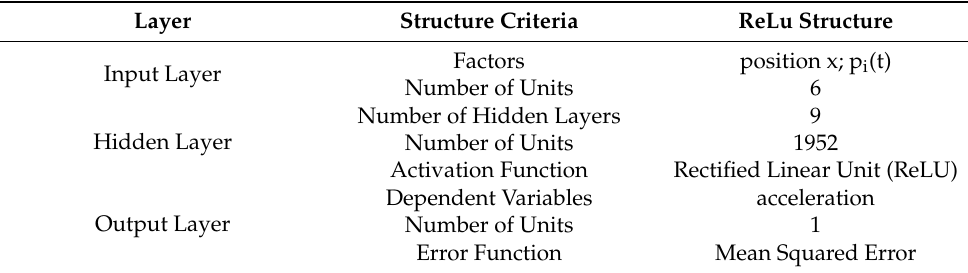
Table 4. Details for ANN structure in this study.